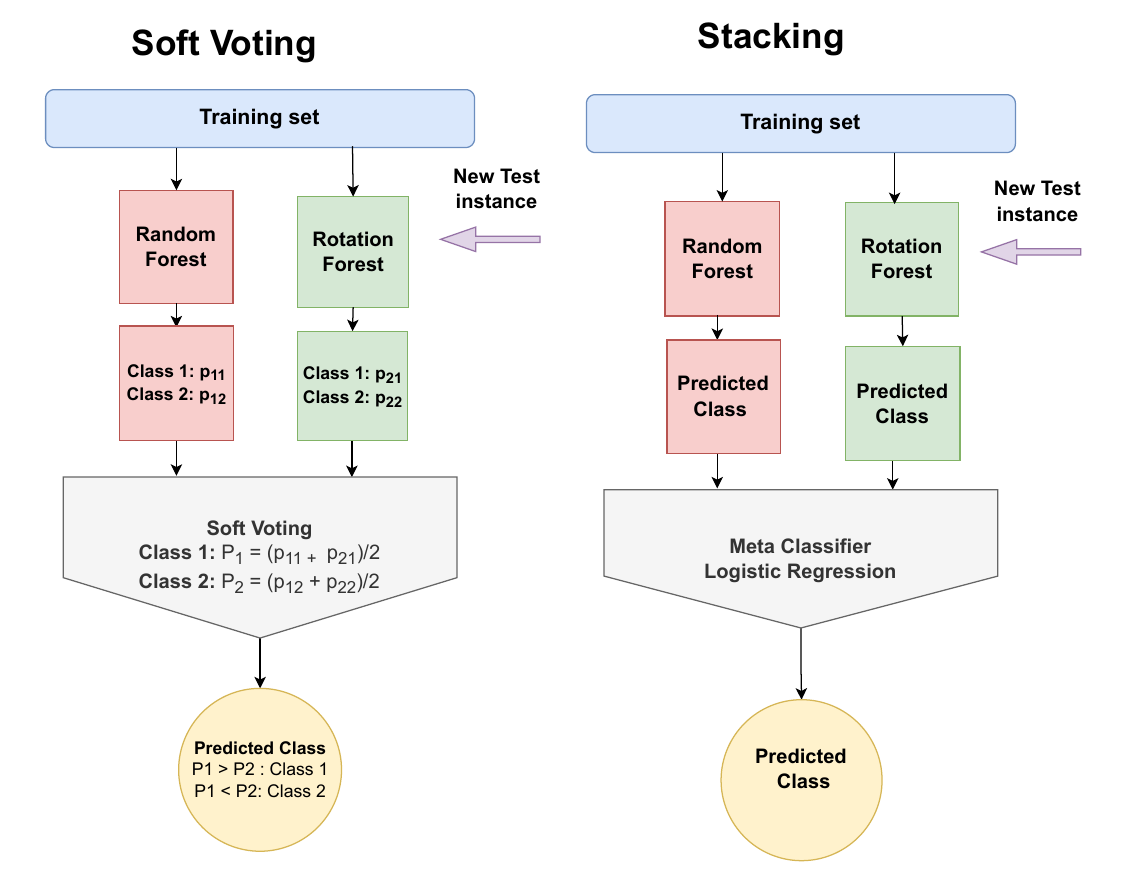
Figure 7. Ensemble Learners: Soft Voting and Stacking.